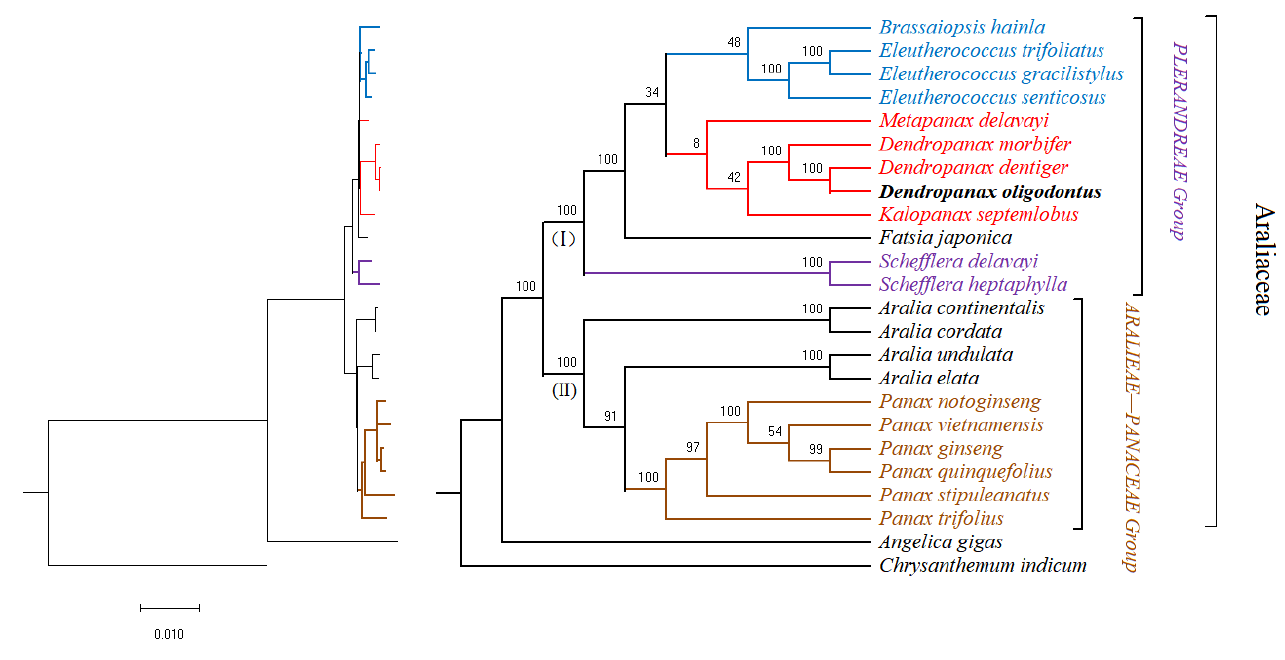
Figure 6. Phylogenetic trees of the Araliaceae species inferred from maximum likelihood (ML) analyses based on the chloroplast genome constructed using coding region data. Support for branches is given by bootstrap values.